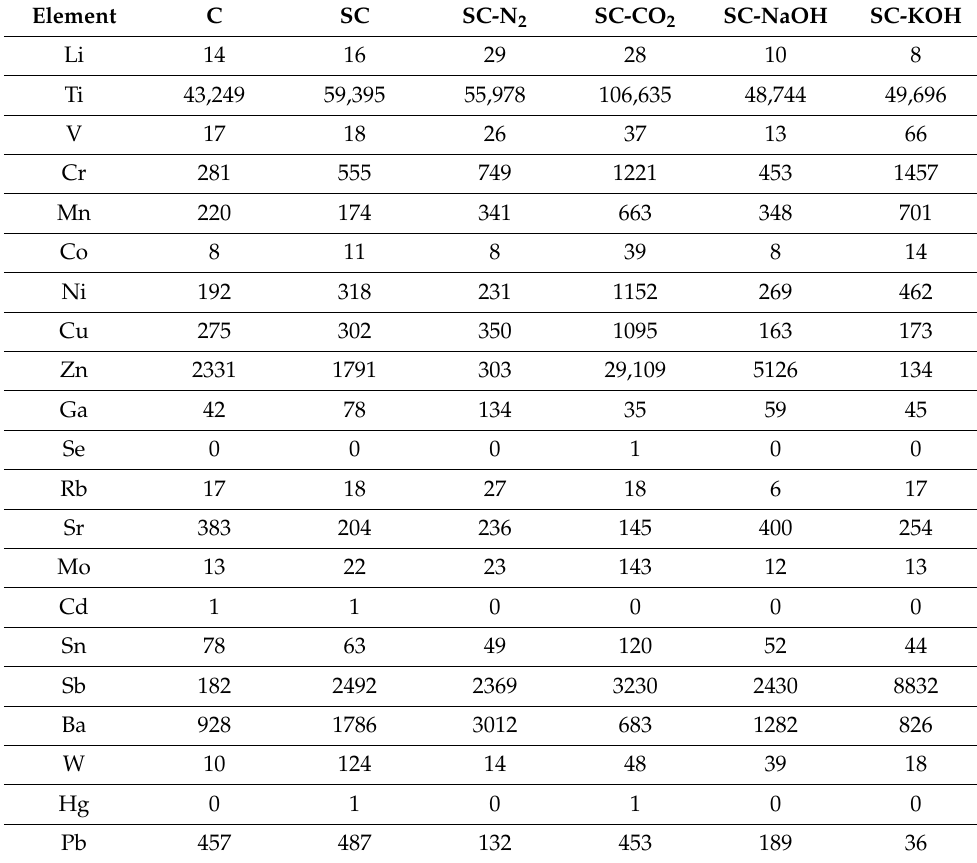
Table 2. Metallic composition (mg · kg − 1 ) of the char from plastic pyrolysis before and after activation.